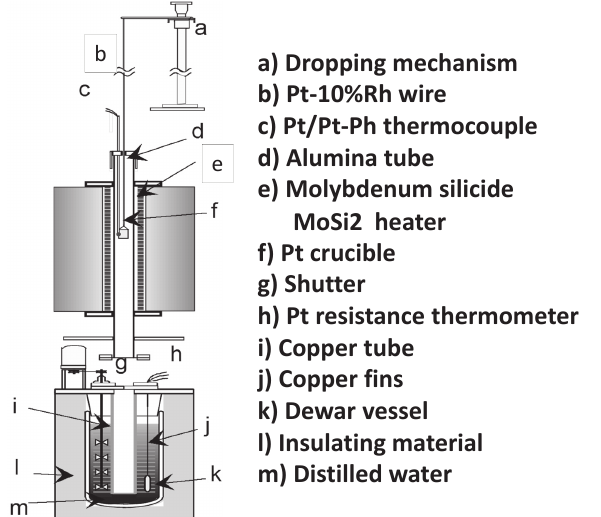
Figure 1. Diagram of drop